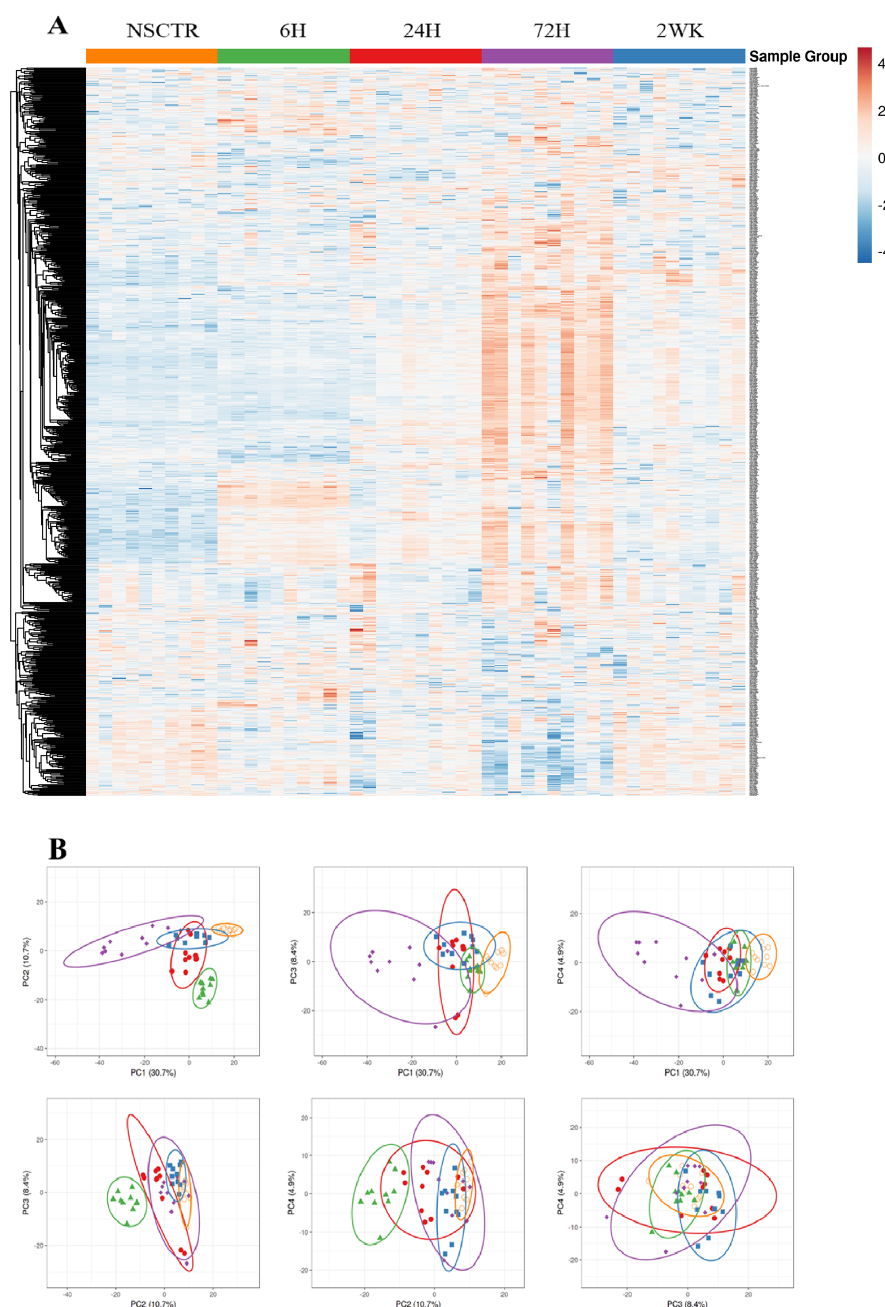
Figure 1. Heat map and principal component analysis. ( A ) Heatmap of gene expression after normalization and log2 transformation. ( B ) principal Component Analysis of normalized log2 transformed data. PC1—PC4 is displayed, and sample groups are marked. The first 4 Principal Component axes account for a total of 55.7% variation in the data. Specifically, PC1 accounts for 30.7% of the variation in data, PC2 accounts for 10.7% of the variation in data, PC3 accounts for 8.4% of the variation in data, and PC4 accounts for 4.9% of the variation in data. New samples are predicted to fall within the elliptical with a probability of 0.95. Orange (open circles) = NSCTR; Green (triangles) = 6-h; Red (circles) = 24-h; Purple (diamonds) = 72-h; and Blue (squares) =